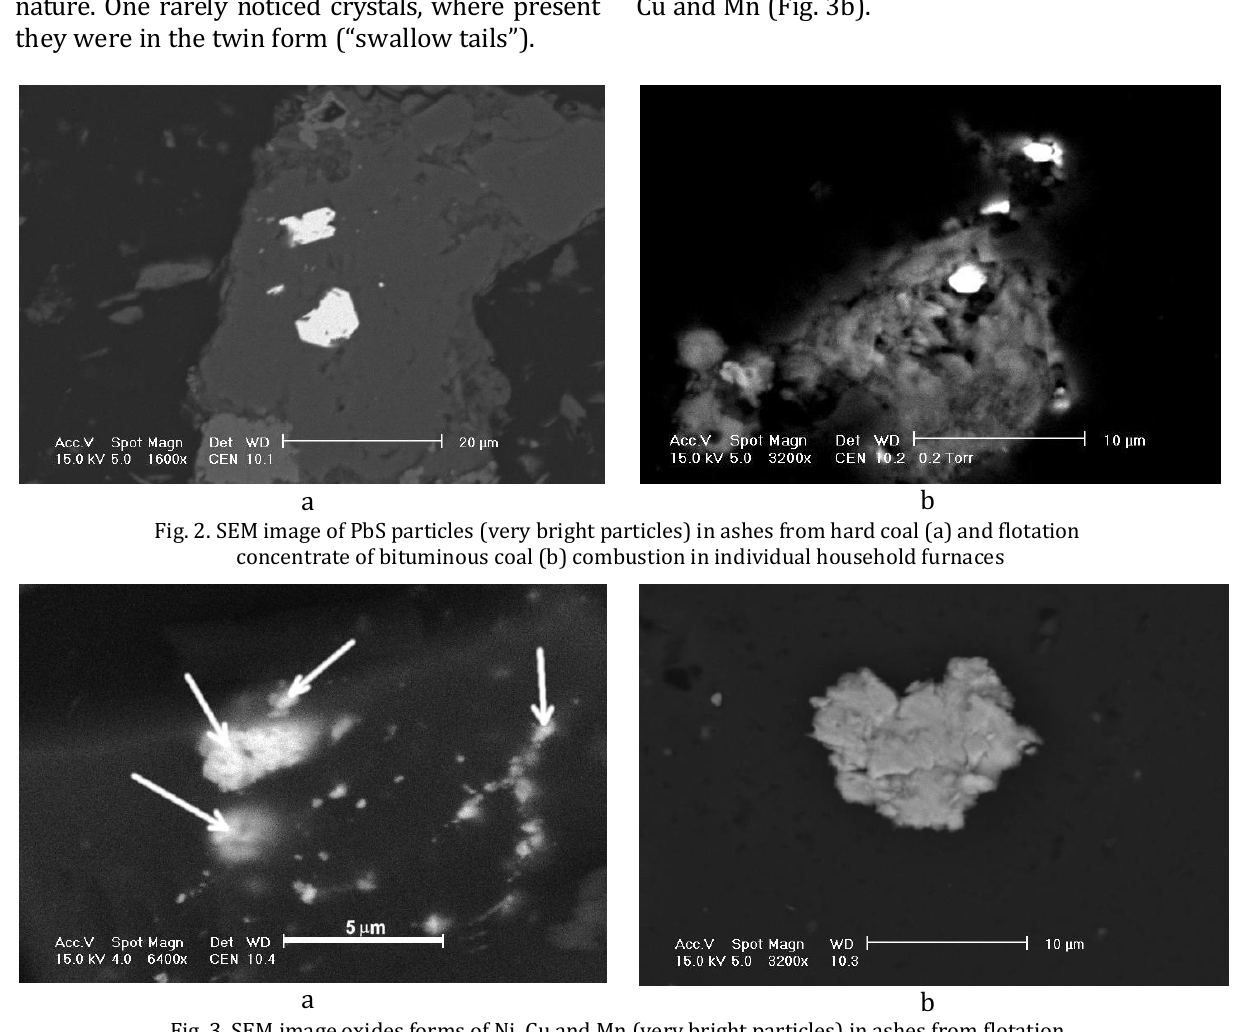
Fig. 3. SEM image oxides forms of Ni, Cu and Mn (very bright particles) in ashes from